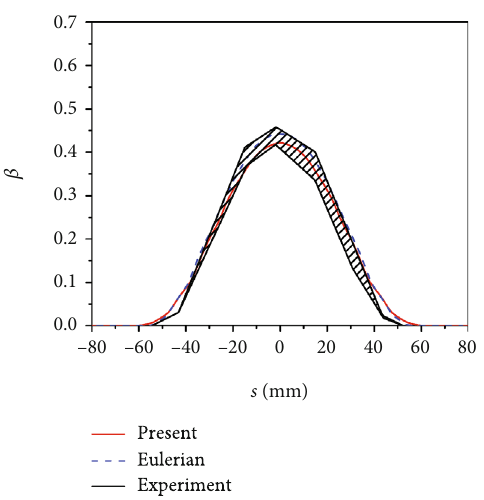
Figure 4: Comparison of collection e ffi ciency with experimental and Eulerian results for the Table 2: The 10-bin droplet size distribution for MVD = 21 μ m . Bin no.